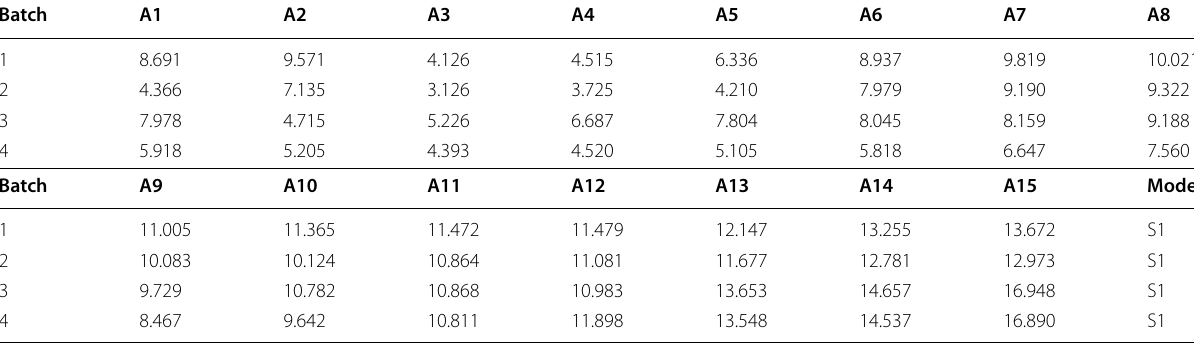
Table 7 Centroid offset data for batches 1–4 of cabin A of model S1